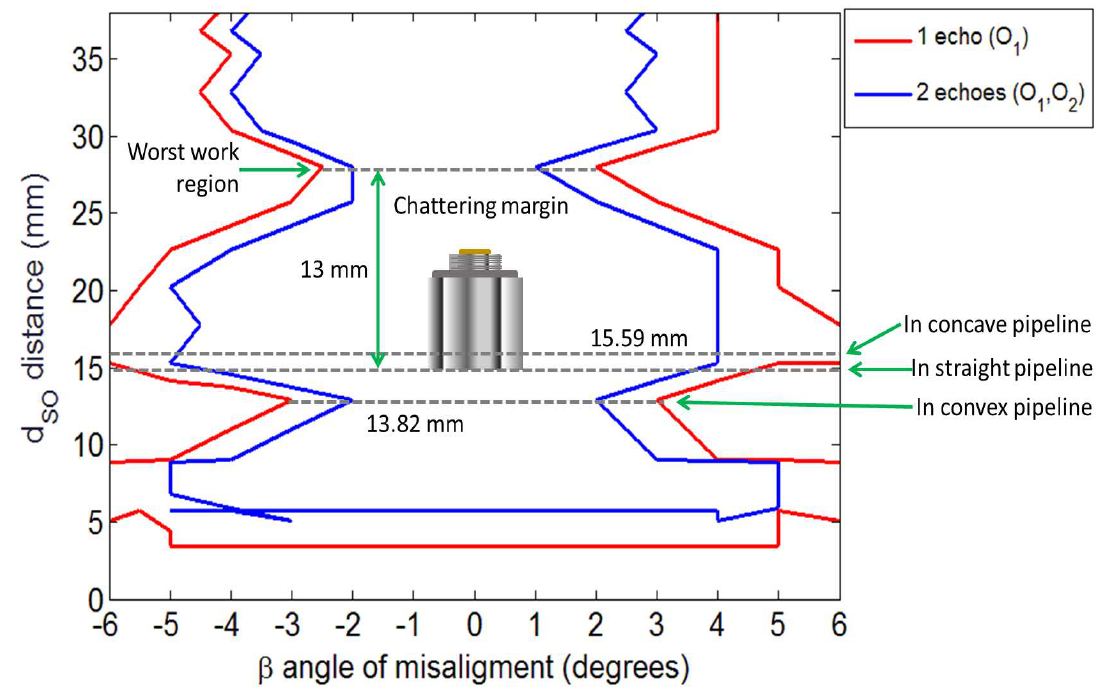
Figure 15. Transducer work area with the parameters of our sensor